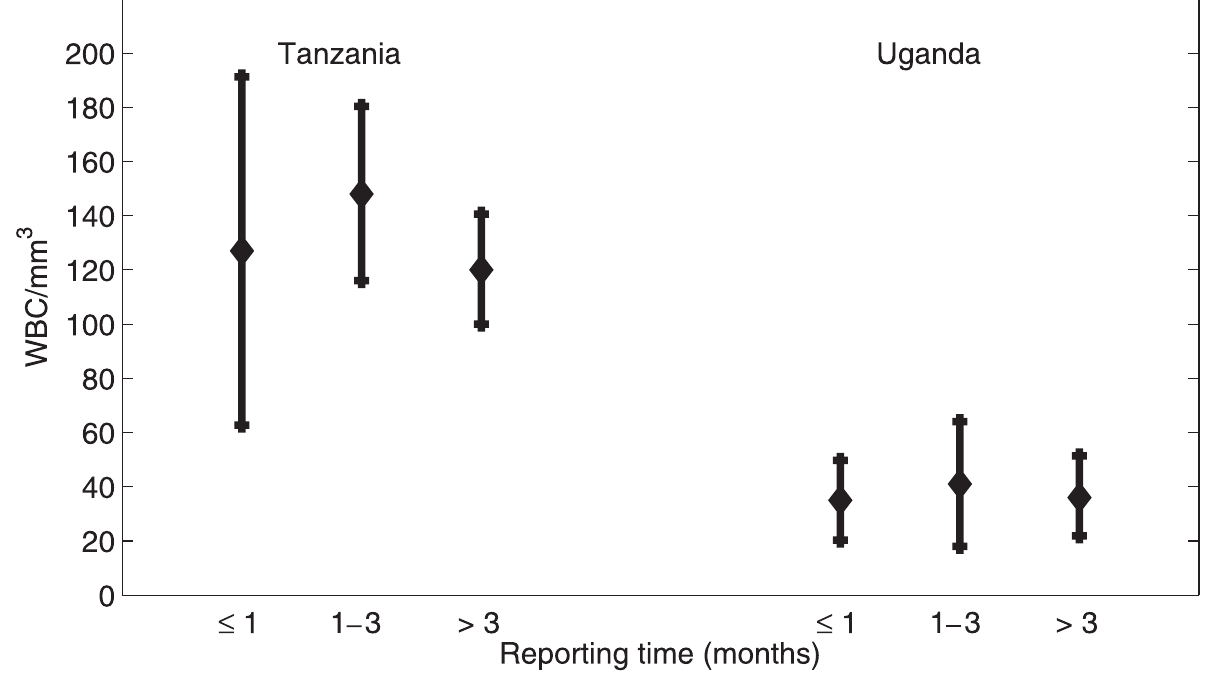
Figure 1. Mean and 95% confidence interval for white blood cell (WBC) count in the central nervous system (CNS) by country and reporting time.